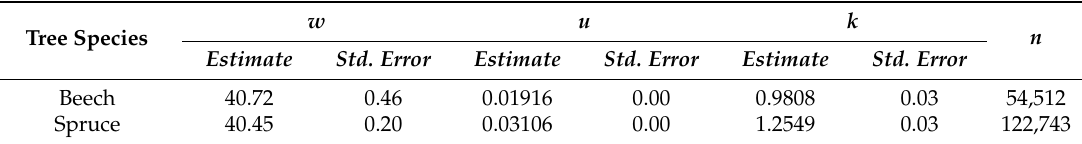
Table 3. Estimates of the h 100 -functions for European beech, Norway spruce (Equation (15); Section 2.2; more detailed database information, see Appendix